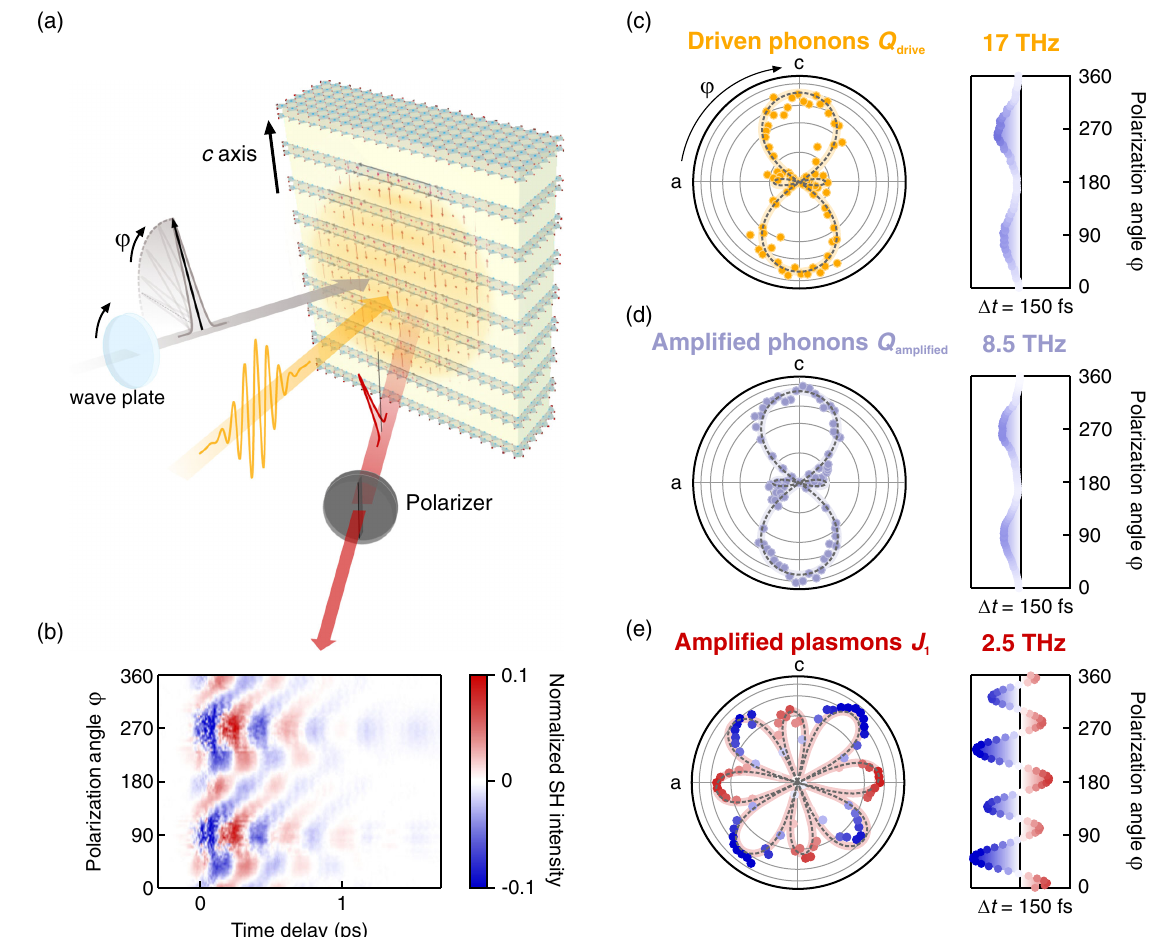
FIG. 3. (a) Schematic of the SH polarimetry geometry. The polarization angle φ of 800-nm near-infrared probe pulses (gray) is controlled by rotating a λ = 2 waveplate. The reflected second-harmonic light (red arrow) passes through an analyzer to measure the different polarization components individually. (b) SH signal as a function of polarization angle and pump-probe time delay, measured at room temperature. (c) – (e) Normalized polarimetry signal of the driven phonons (yellow dots), amplified phonons (gray dots), and amplified JPPs (red and blue dots) for an analyzer oriented along the crystal ’ s c axis, at one time delay t ¼ 150 fs. The SH polarimetry signal of the two sets of phonons can be reproduced by a fit to a second-harmonic tensor with mm 2 point group symmetry (dashed line) and the phase of the oscillations is polarization angle φ independent. The polarimetry signal of the amplified JPP agrees with a fit to a point group of lower symmetry (dashed line), in which at least two mirrors are lost. The phase of the coherent oscillations is periodically modulated with polarization angle φ , indicated by the red and blue color coding. The SH polarimetry data were recorded at room temperature with a peak field strength of ∼ 5 MV =